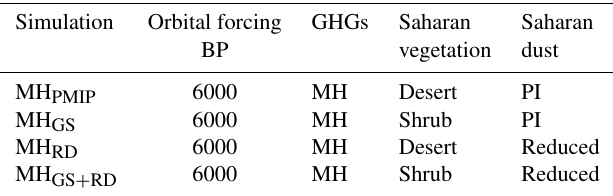
Table 1. Boundary conditions for all MH experiments.